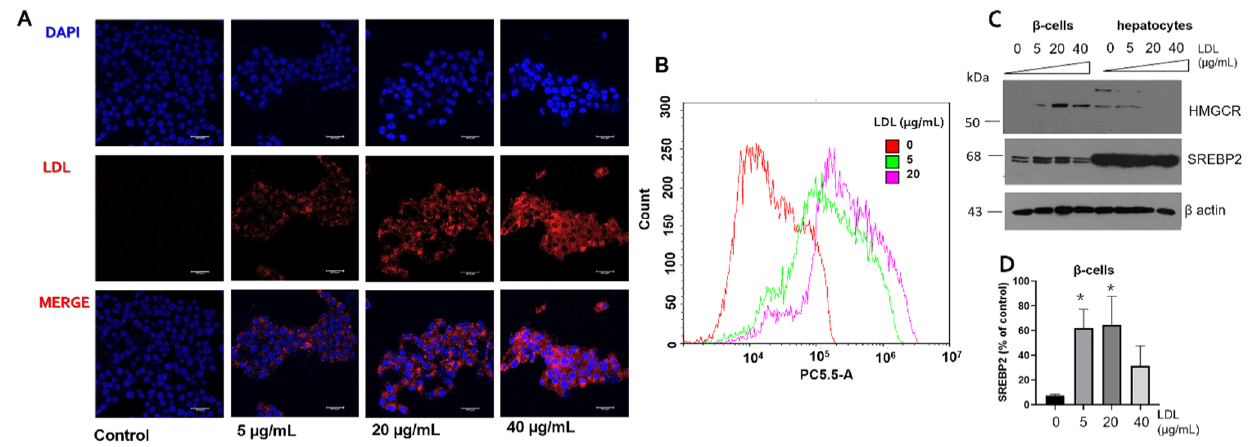
Figure 1. LDL endocytosis in β-cells is associated with the alteration of cholesterol targets. ( A ) RIN-m5F cells were treated with increasing concentrations of dil-LDL (0–40 µg/mL), representative images showing Hoescht (blue), dil-LDL (red), and merge for each treatment. ( B ) Flow cytometry analysis of dil-LDL endocytosis (0–20 µg/mL), under incubation for 20 h. PBS was used as a vehicle. ( C ) Effect of LDL treatment (0–40 µg/mL) on the expression of HMGCR and SREBP2 in β-cells, hepatocytes were evaluated as a control. ( D ) Densitometry analysis of SREBP2 in β-cells, results are reported as mean ± SD ( n = 3), * p < 0.05 concerning control. β-actin was used as a loading control.